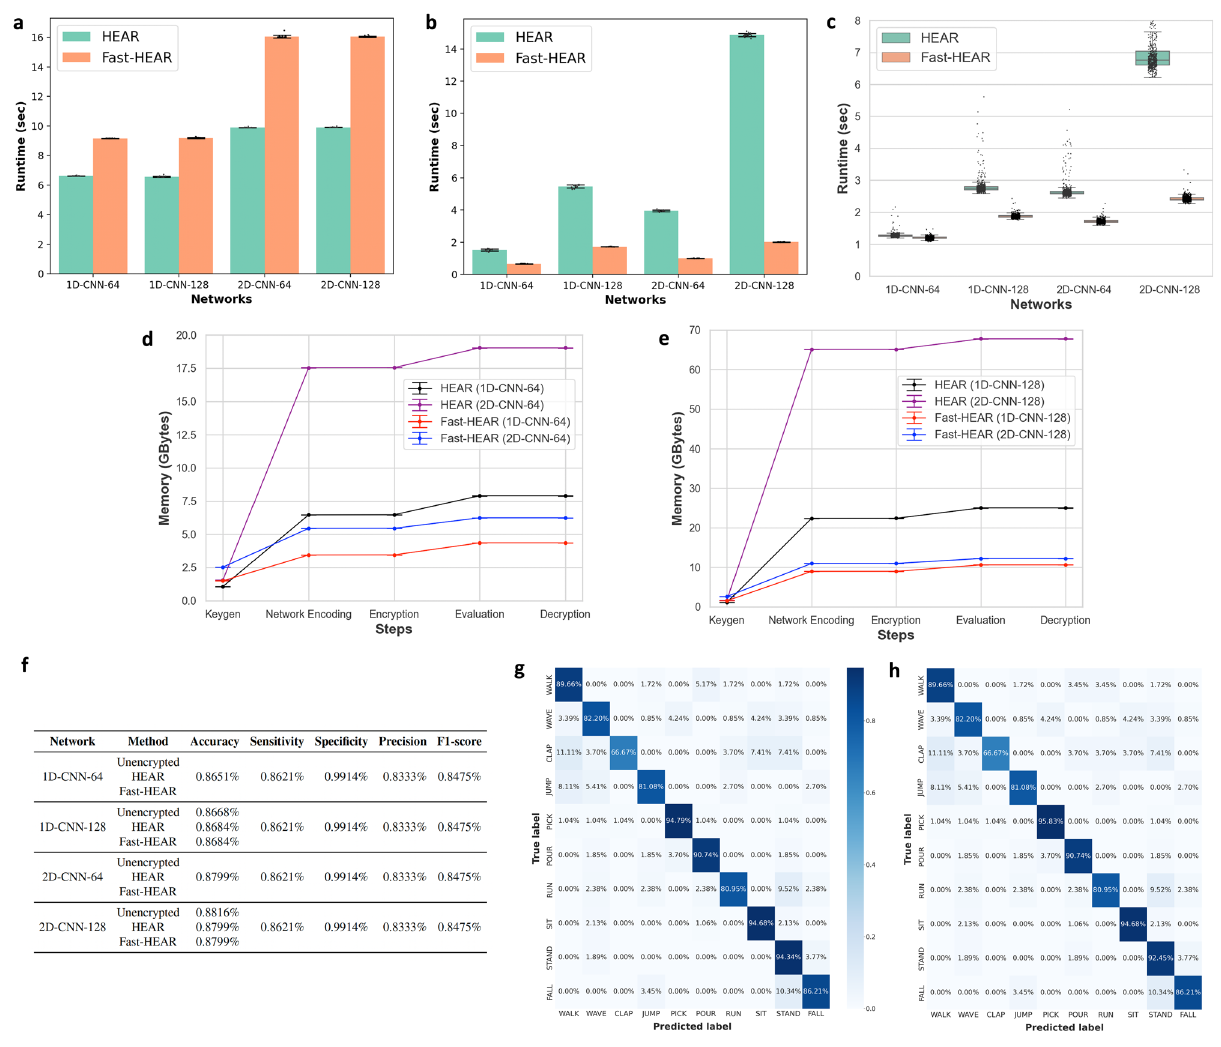
Fig. 4 | Experimental results of secure action recognition inference over var- ious CNN networks. a Running time required to generate all required crypto- graphickeysforsecurecomputation.Dataarepresentedasmean±s.d.from n =20 independent experiments. b Running time for encoding the weight parameters. Dataarepresentedasmean±s.d.from n =20independentexperiments. c Average runningtimeforsecureinferenceon n =608independentsamplesfromthetestset over various neural network models. Boxplot displays the median values with the fi rst and third quartiles, and the whiskers boundaries extend to the largest and